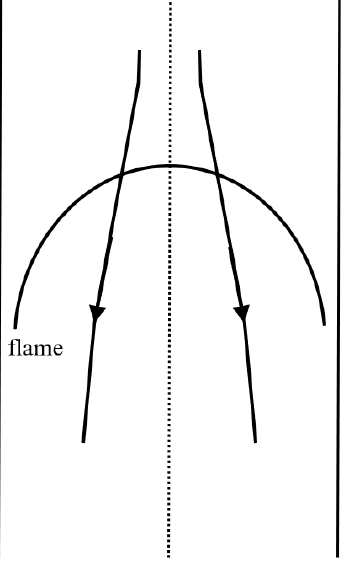
Figure 19. Straining flow is generated by rising hot gases. Reproduced from Ref. [19], The Combustion Institute: 1982.